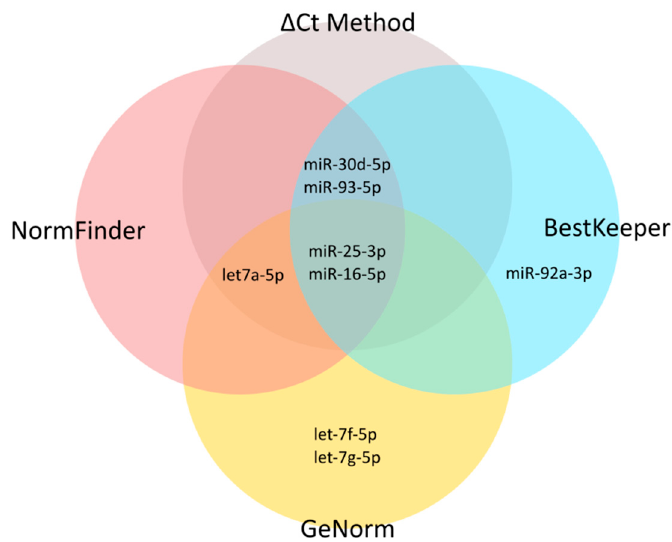
Figure 4. Venn diagram presenting the overlap between the five most stable candidate miRNAs indicated by each of four stability-testing algorithms. indicated by each of four stability-testing